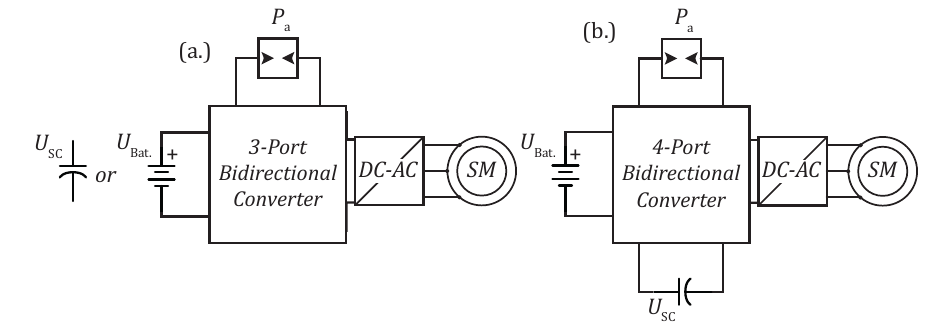
Figure 2. Overview of the possible connections of the energy distributions converter: ( a ) A 3-Port bidirectional converter for battery or super-capacitor (single energy storage system); ( b ) A 4-Port bidirectional converter with combination of battery and super-capacitor-module (hybrid energy storage system).